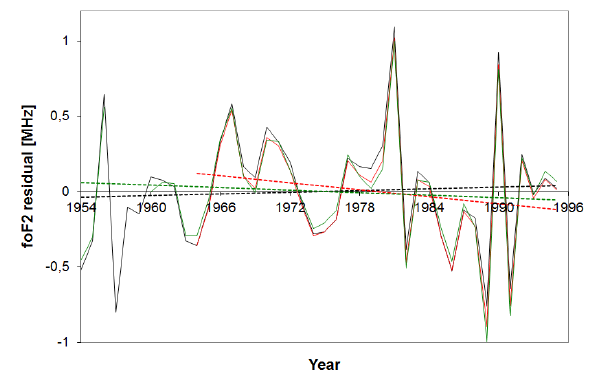
Figure 2. foF2 residual (June, 12 LT) for Slough assessed for the pe- riods: 1954-1995 (black line), 1964-1995 (red line), 1954-1995 ex- cluding periods where F10.7 exceeded 200 (green line). Dotted lines are the corresponding linear